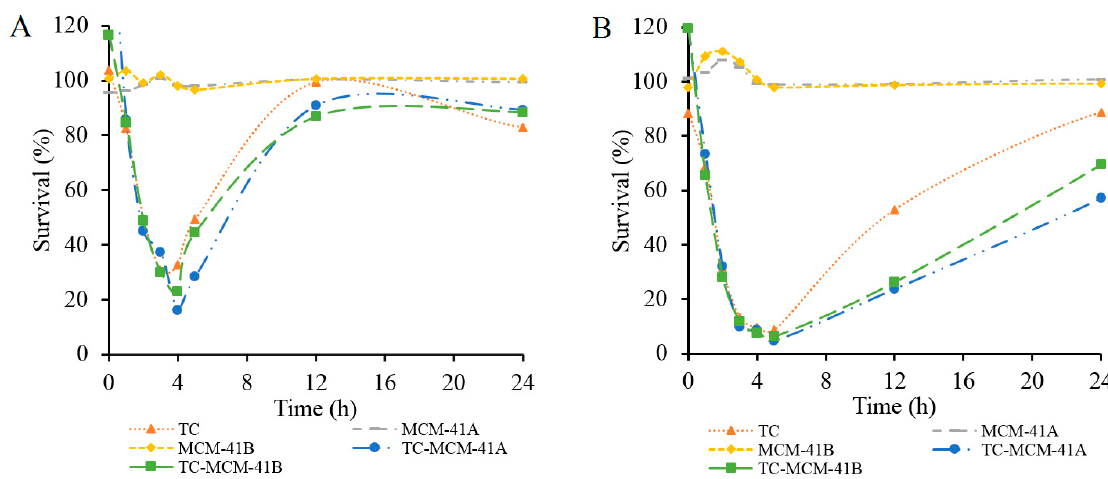
Figure 5. Survival (%) of E. coli treated by TC, MCM-41A, MCM-41B, TC-MCM-41A and TC-MCM-41B, determined using UV-vis spectroscopy. ( A ) TC concentration: 0.5 µg/mL and ( B ) TC concentration: 1.0 µg/mL. In each group, the concentration of free TC was the same as the concentration of TC in TC-MCM-41A and TC-MCM-41B, and concentrations of MCM-41A and MCM-41B corresponded to concentrations of TC-MCM-41A and TC-MCM41B,